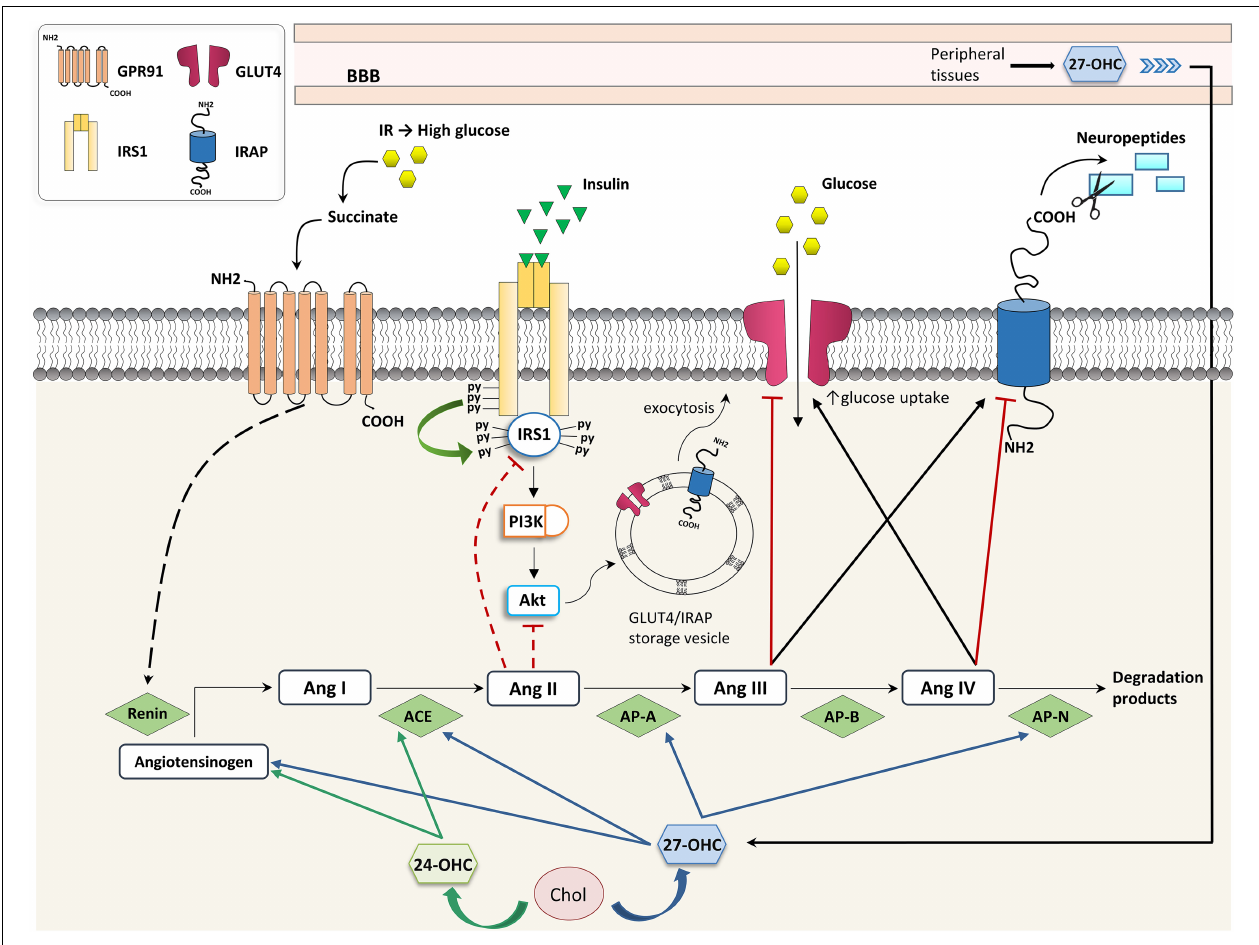
FIGURE 2 | Effects of oxysterols on RAS- and insulin-dependent glucose uptake. 24-OHC, 24-hydroxycholesterol; 27-OHC, 27-hydroxycholesterol; ACE, angiotensin I-converting enzyme; Ang, angiotensin; AP, aminopeptidase; BBB, blood-brain barrier; Chol, cholesterol; GLUT, glucose transporter; GPR91, G-protein-coupled receptor 91; IR, insulin resistance; IRAP, insulin-regulated aminopeptidase; IRS, insulin receptor substrate; and PI3K, phosphoinositide